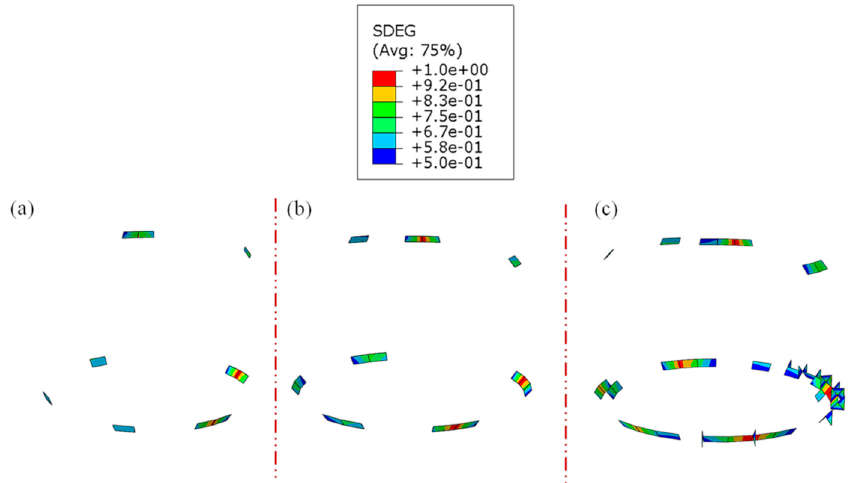
Figure 12. Fatigue damage associated with No. 2 random field and under axial load ( a ) 8433 N, ( b ) 8685 N, and ( c ) 8936 N.